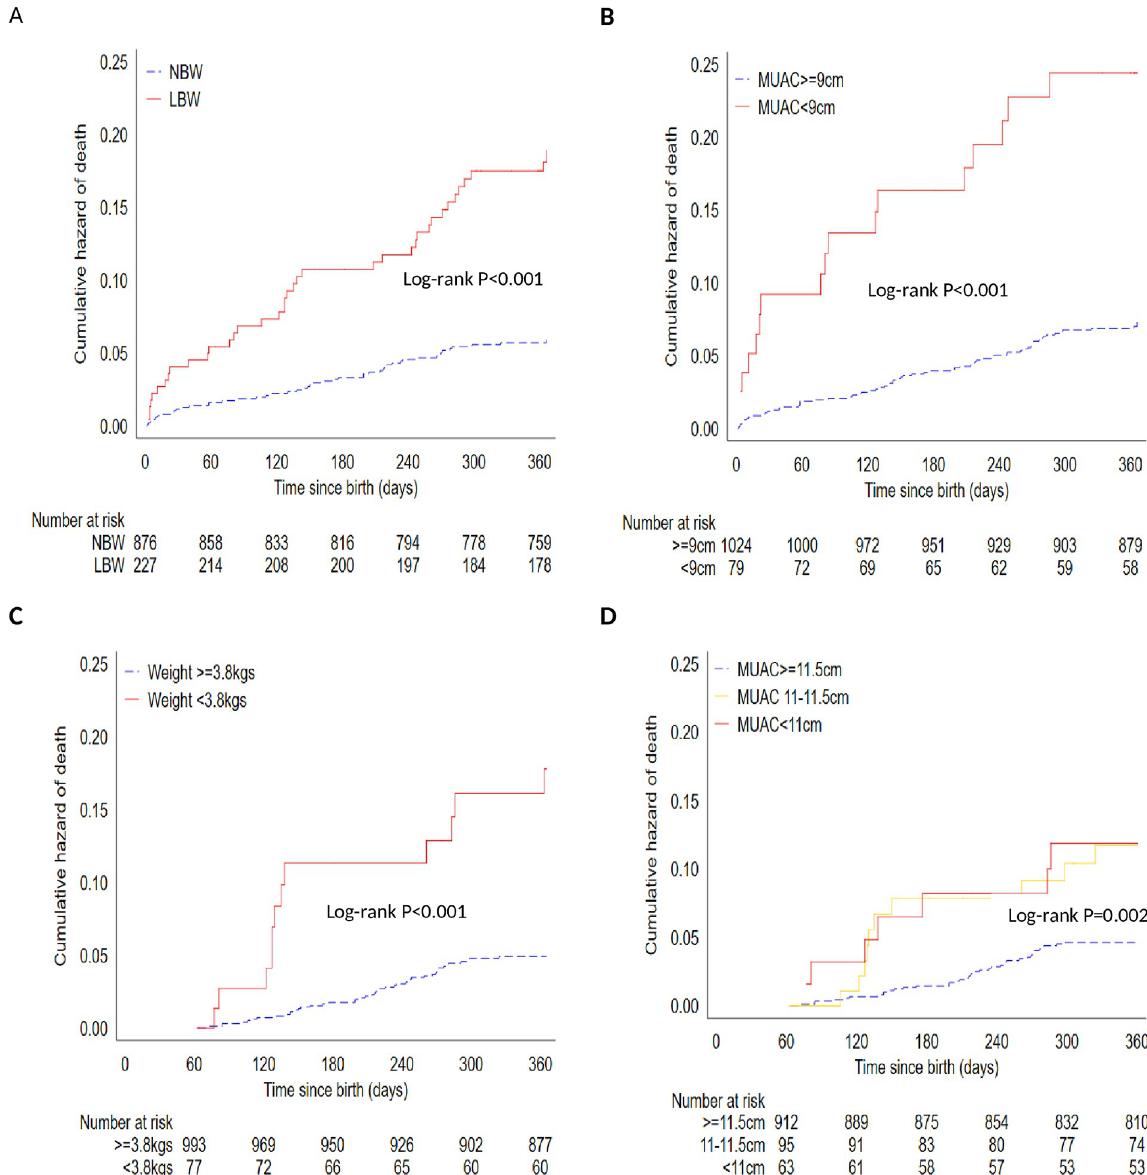
Fig 1. Nelson-Aalen cumulative hazard of one-year mortality. A: stratified by LBW, B; stratified by Birth MUAC < 9.0 cm, C; stratified by month two weight < 3.8kg and D; stratified by month two MUAC.